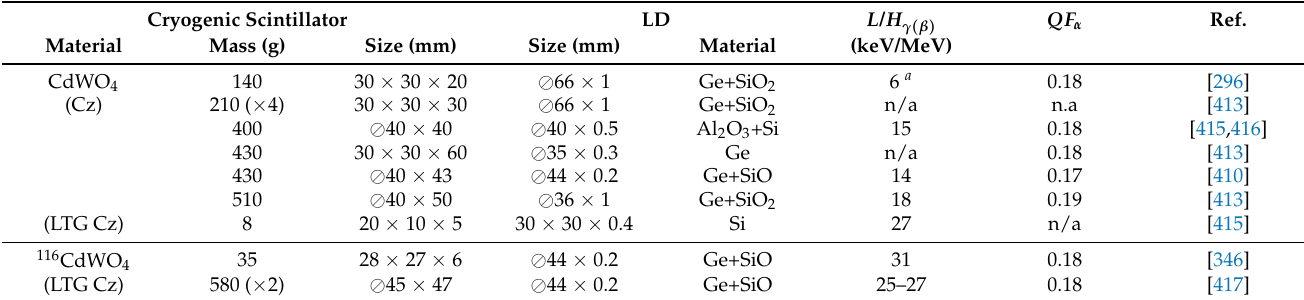
Table 4. Results of low-temperature scintillation detection with scintillating bolometers based on natural/ 116 Cd-enriched CdWO 4 crystals and thin bolometric light detectors (LDs). The crystal growth method, the mass (two significant digits) and the size of the sample, the size and the material (including coating) of the coupled LD, as well as the L / H γ ( β ) and QF α values are